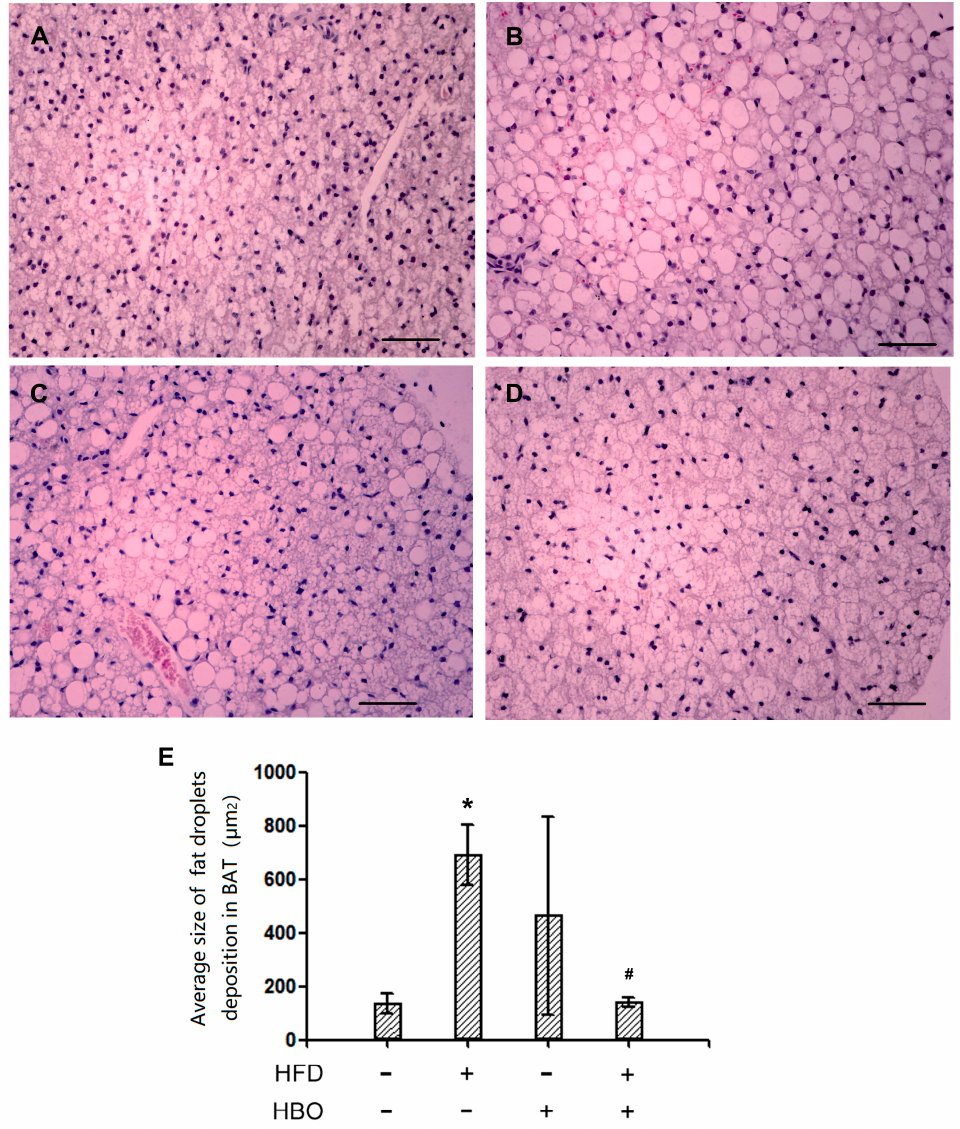
Figure 3. Hematoxylin and eosin staining of BAT. BAT tissues were fixed in 4% paraformaldehyde 24 h, and then histologically processed and sectioned at thickness of 6 um. Hematoxylin and eosin staining was performed following manufacturer’s instructions. Quantification was performed with ImageJ. Three samples from three independent animals were assessed per group. Error bars represent standard derivation. Scale bars represent 50 um. ( A ): Representative hematoxylin and eosin staining picture of BAT from control animals. ( B ): Representative hematoxylin and eosin staining picture of BAT from high fat diet (HFD)-treated animals. ( C ): Representative hematoxylin and eosin staining picture of BAT from HBO-treated animals. ( D ): Representative hematoxylin and eosin staining picture of BAT from HFD + HBO-treated animals. ( E ): Quantification of the average size of fat droplets. *: statistically di ff erent from control group animals ( p < 0.05). #: statistically di ff erent from HFD group animals ( p <